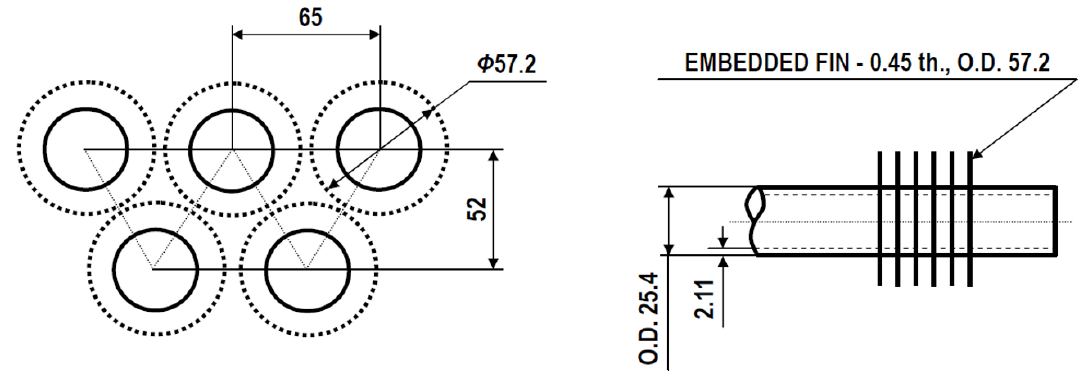
Figure 2. Steam air heater tube arrangement and tube detail.